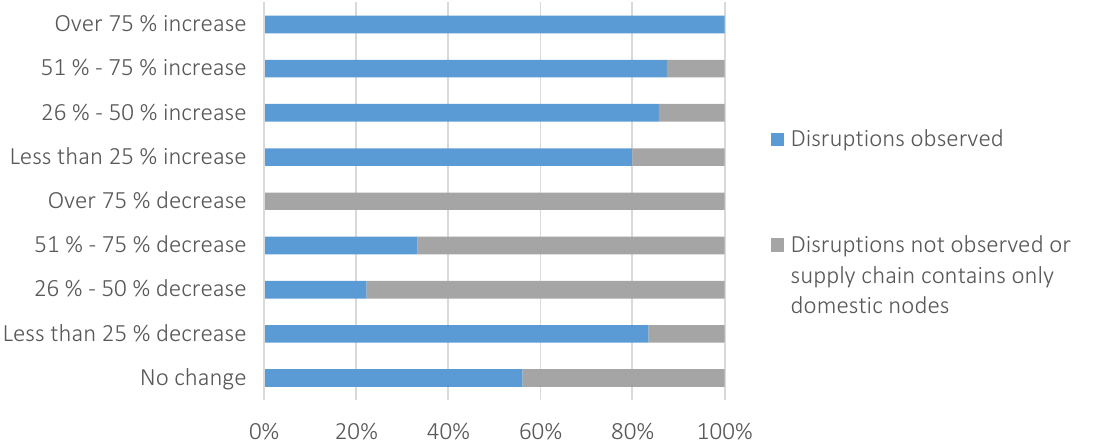
Figure 1. Changes in revenues based on disruptions in international supply chain nodes